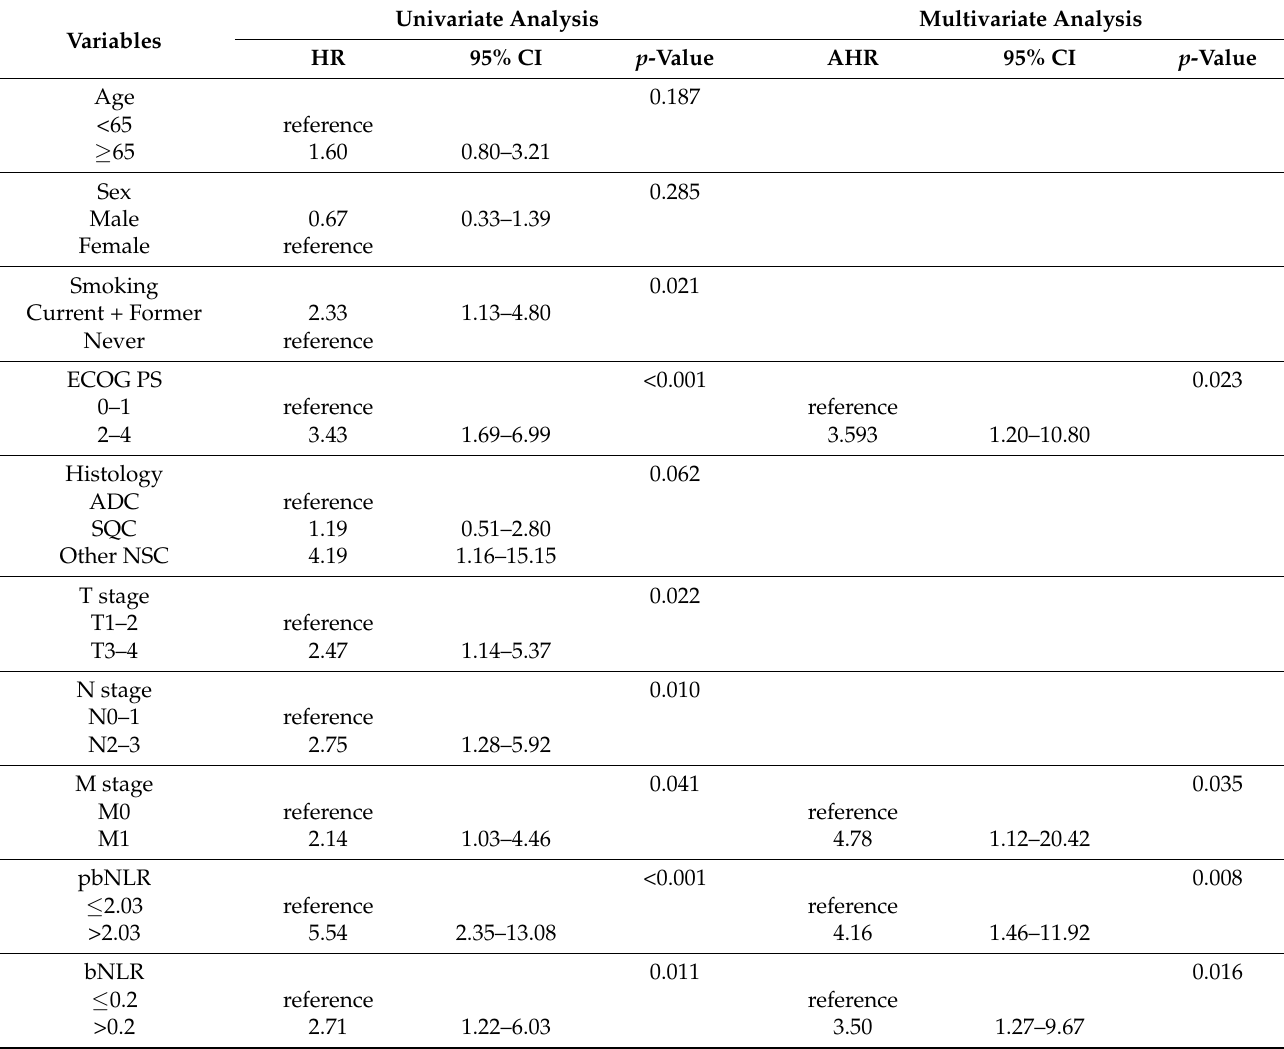
Table 3. Univariate and multivariate analyses of factors predictive of overall survival in all